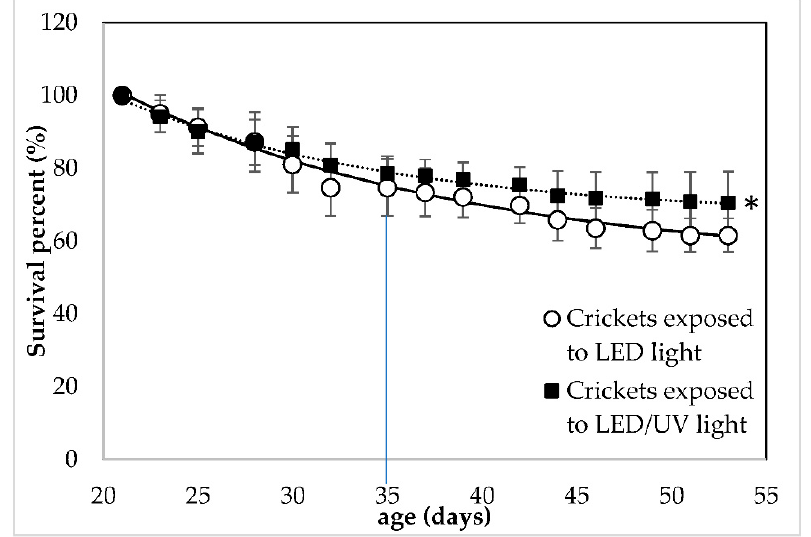
Figure 2. Survival percent (%) of Acheta domestica reared Under LED without ( ○ ) and with narrowband UV-B irradiation at 285 nm ( ▪ ). Error bars represent the standard deviation of multiple replications of the measurements ( n = 5). Dashed lines represent the fitting of experimental data to Equation (4). The small line that is vertical to the x -axis indicates the time when crickets reached adulthood (35 days of age) and (*) indicates significant differences between data obtained from different treatments.